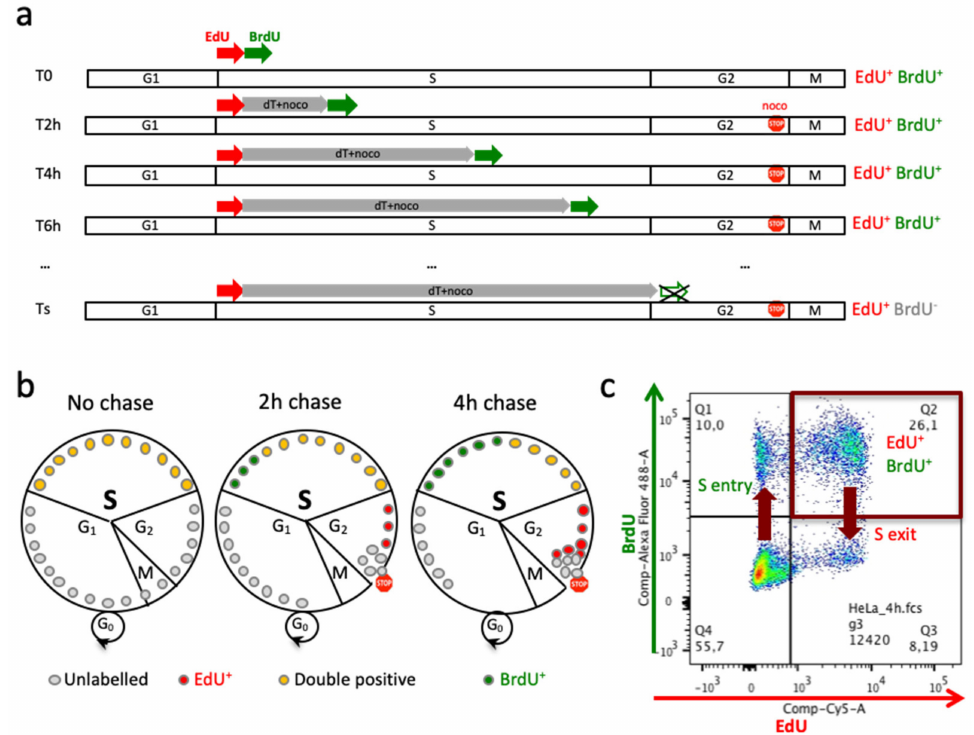
Figure 1. Principle of the method. ( a ) Asynchronous cells are pulse-labeled with EdU, then with BrdU for 30 min (T 0 ). Other samples get the same two pulses, but separated by a thymidine chase period lasting 1.5, 3.5, 5.5 (T 2 , T 4 , T 6 ); nocodazole is added to prevent progression to the next cycle. DNA synthesis time (T S ) is the time when the earliest EdU + cell is no more labelled with BrdU. ( b ) Illustration of cells (circles) progressing through the cell cycle, labelled with EdU (red), BrdU (green) or both (yellow), at T 0 (no chase) or after intervening thymidine chases (2 h, 4 h). ( c ) An example of FACS analysis on HeLa cells double-labelled with 4 h thymidine chase. After staining with an anti-BrdU antibody and a fluorescent azide, double-positive, double-negative and single (EdU or BrdU) positive cells can be identified and scored by cytometry. EdU − cells that become BrdU + are those entering S phase during the interval between the two pulses (S entry); conversely, double-positive cells that become BrdU − are those exiting S phase during the interval between the two pulses (S